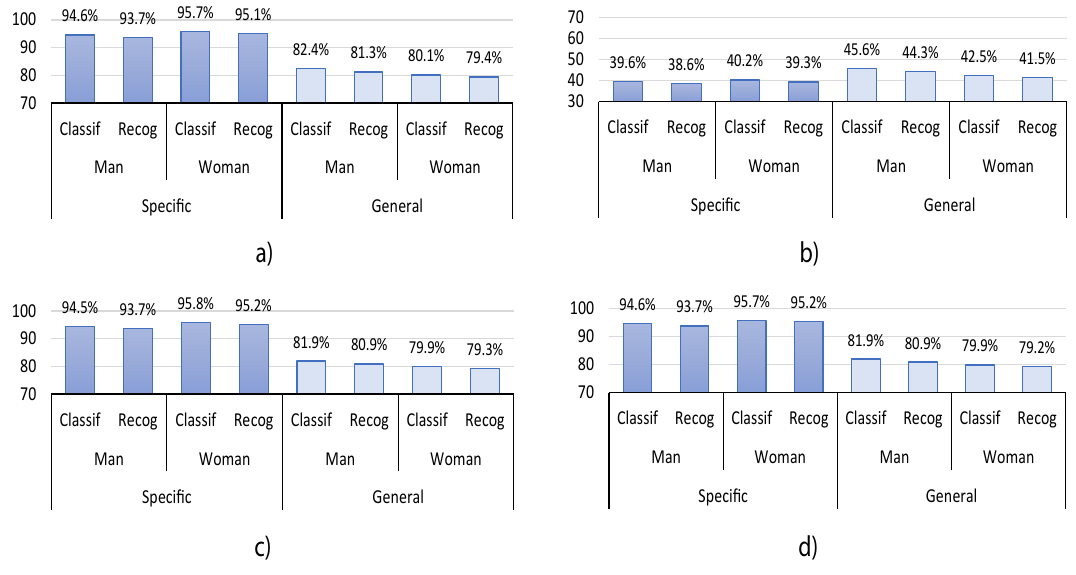
Figure 9. HGR classification and recognition accuracy results considering user’s sex information for user-specific and user-general models obtained for ( a ) experiment 1 , ( b ) experiment 2 , ( c ) experiment 3 , and ( d ) experiment 4